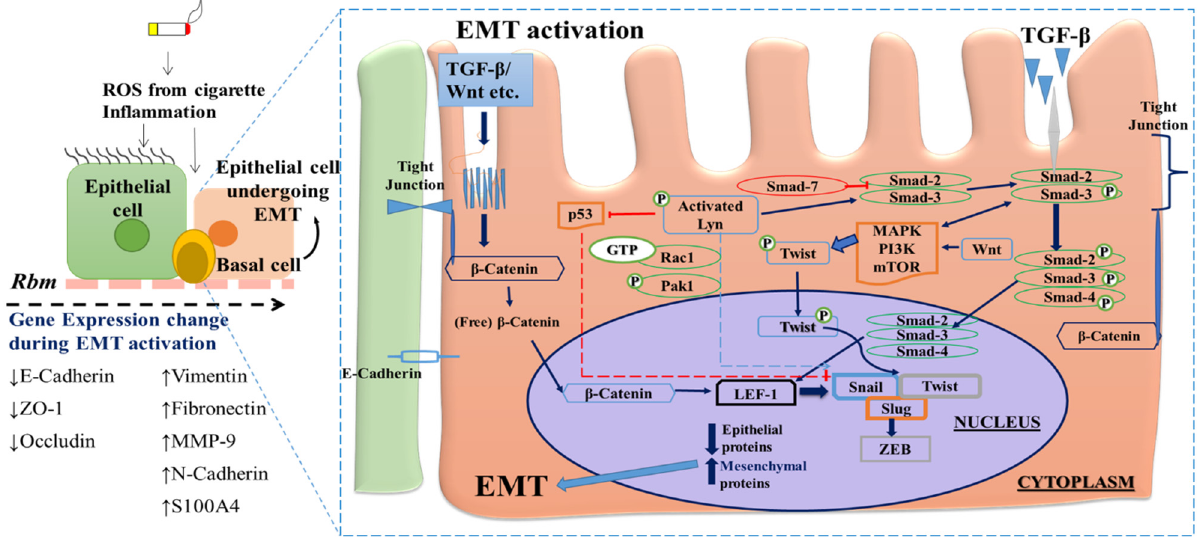
Figure 1. Epithelial-Mesenchymal Transition (EMT)-associated pathways/transcriptional factors as potential therapeutic targets. External stimulus (such as cigarette smoke, pollutants, and luminal infection/inflammation) “activate” the airway epithelium resulting in the increased production of transforming growth factor- β (TGF- β ) and other EMT drivers (e.g., Wnt). The sequence is generation of basal (stem) cell signalling molecules (e.g., β -catenin, SMADs and kinases), then elevation of activity of gene transcription factors (e.g., Snail, Twist, Slug etc.), and finally production of EMT-related mesenchymal proteins and suppression of normal epithelial markers.